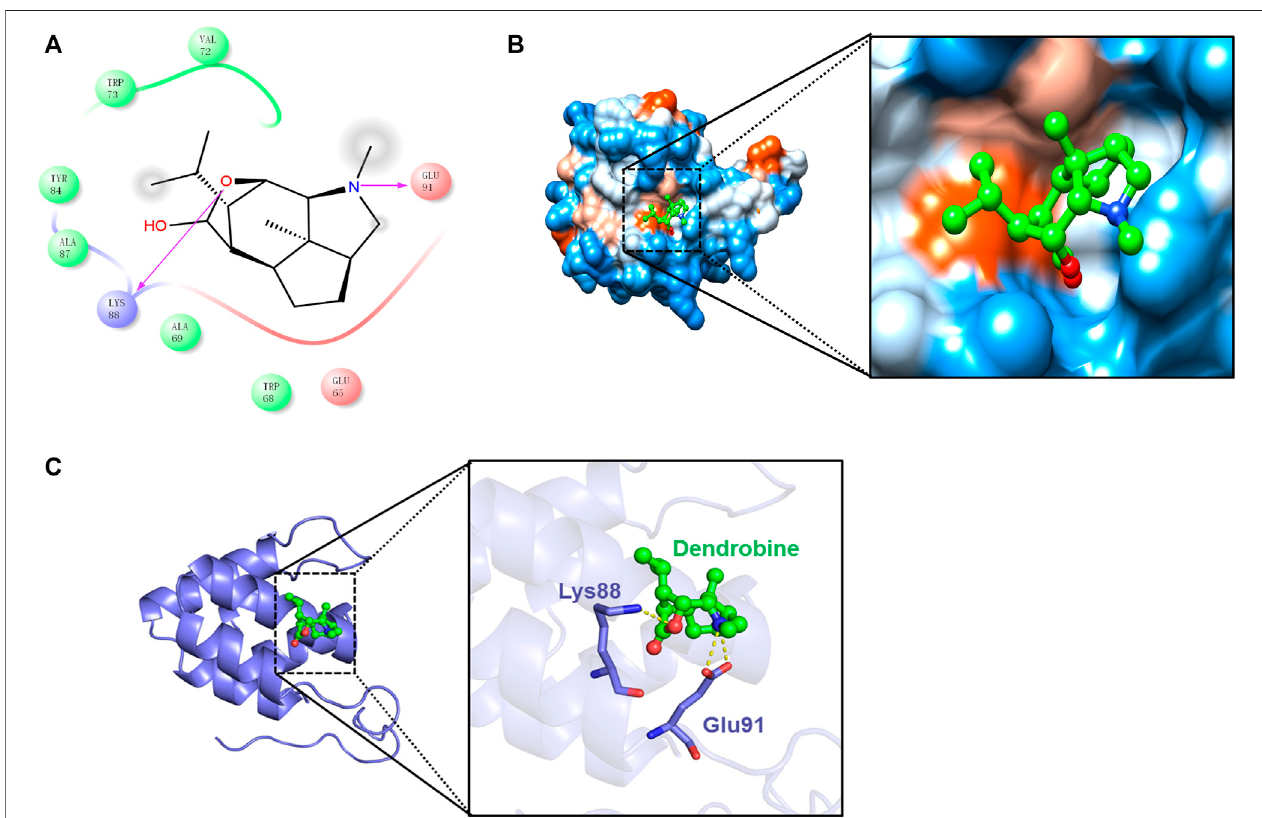
FIGURE 5 | Molecular docking of the DNLA and NLRP3 complex. Residues of amino acids between DNLA and NLRP3 complex (A) . Binding of DNLA to the hydrophobicsurfaceoftheNLRP3protein;hydrophilic(blue)andhydrophobicparts(orange)oftheproteinsurface (B) .Overviewofthepredictedbindingmodebetween GSDMD-N and NLRP3 (C)